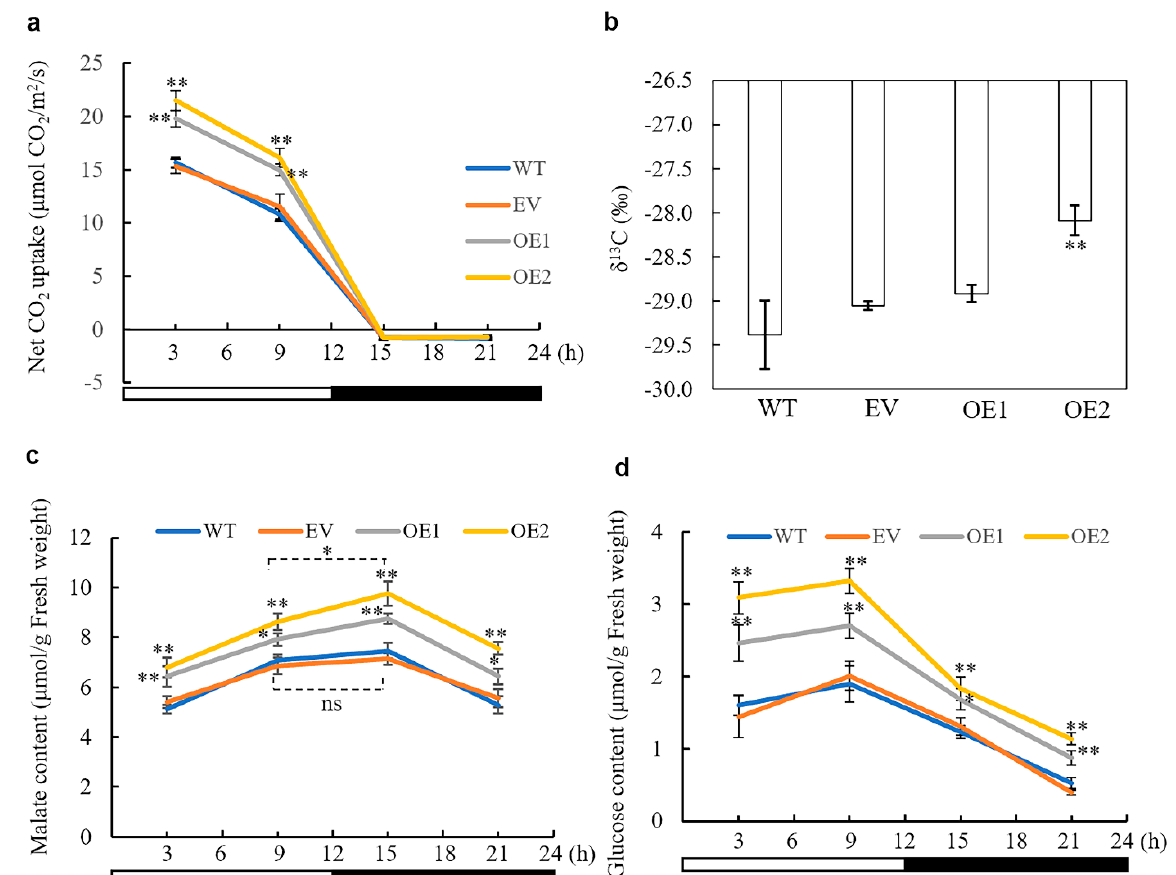
Figure 3. Impact of overexpressing AaPEPC1 on photosynthetic rate ( a ), carbon isotope ratio δ 13 C ( b ), malate content ( c ), and glucose content ( d ) in tobacco. OE1 and OE2: the transgenic plants expressing AaPEPC1. EV: empty vector control. WT: wild-type plants. White and black bars indicate the light period (12 h) and the dark period (12 h), respectively. X -axis represents the time after the beginning of the light period at 00:00 h. Values represent means ± SD (n = 3 individual replicate plants). * and ** indicated significant difference from that of WT at p < 0.05 and p < 0.01, respectively, by one-way ANOVA analysis with a post-hoc Tukey honestly significant difference (HSD) test. Ns =